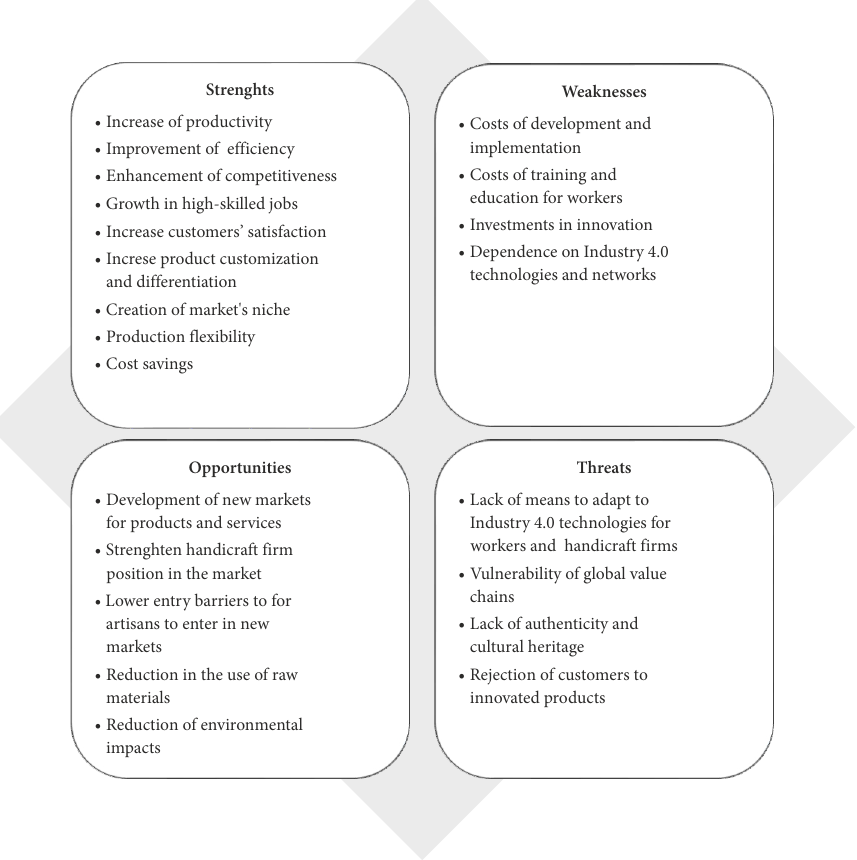
Figure 1. SWOT analysis conducted on the basis of the reviewed theoretical